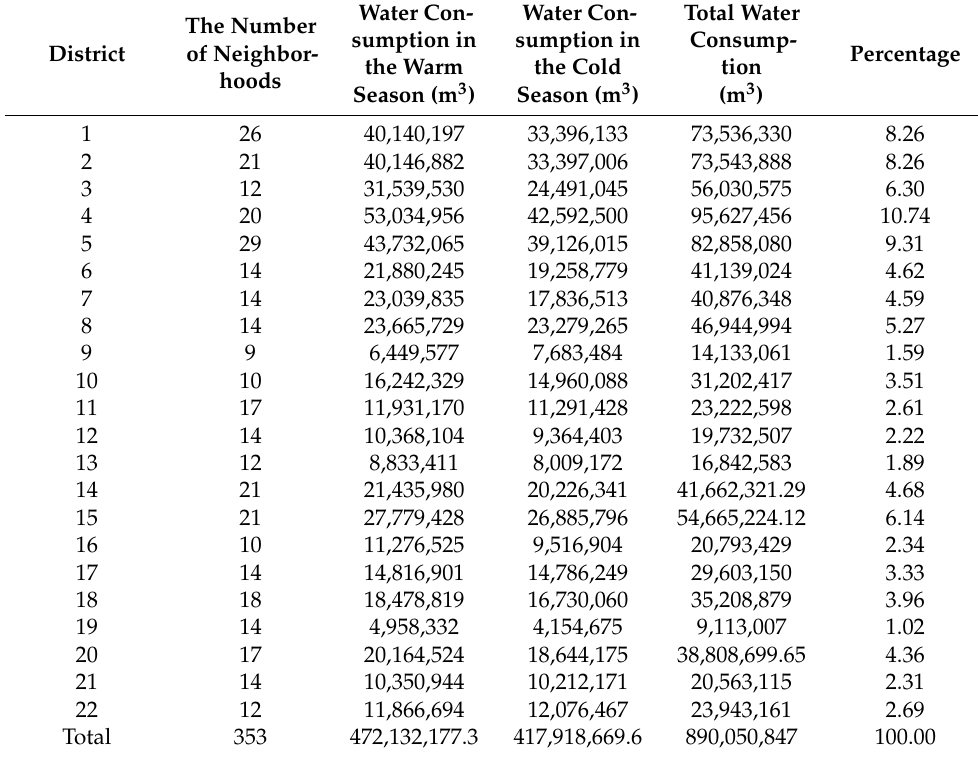
Table 8. Amount and percentage of water consumption in the districts of